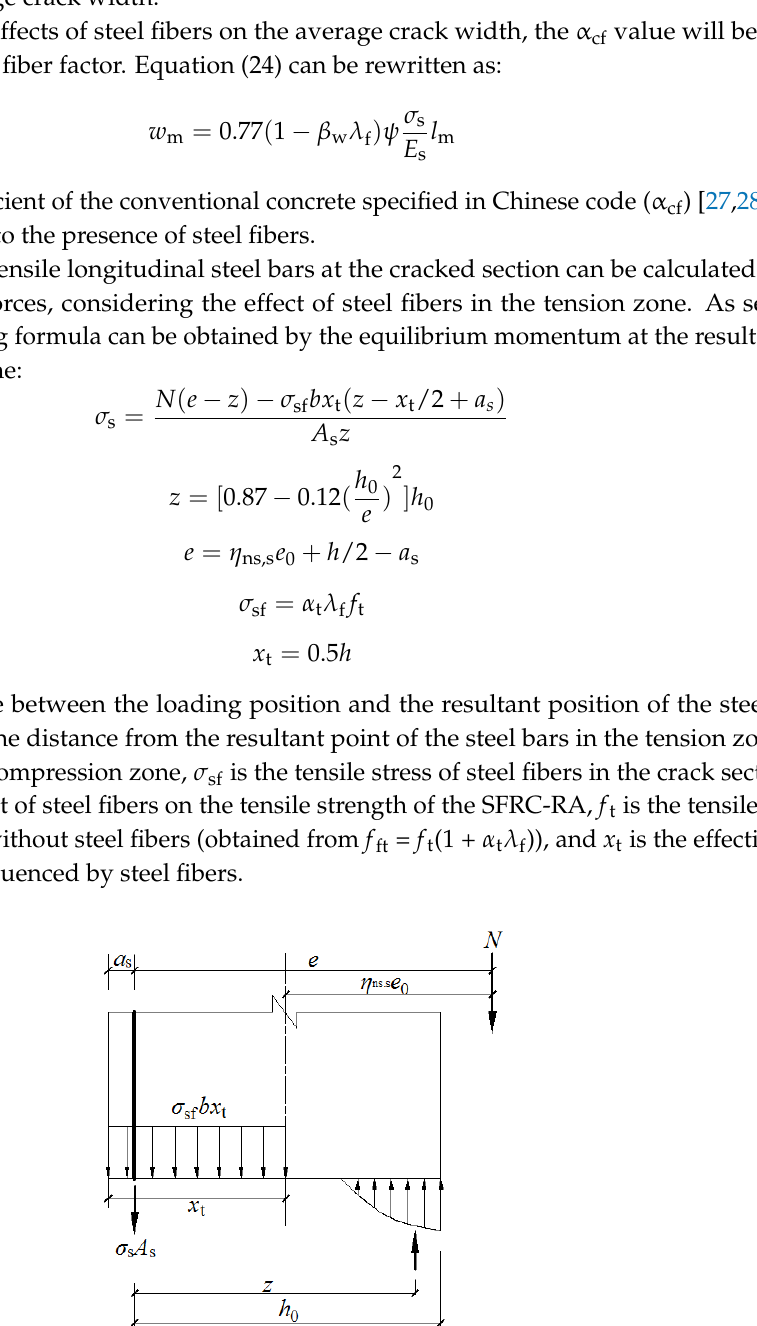
Table 9. The calculated and tested values of the average ( w m ) and maximum crack width ( w max ) of the tested columns.